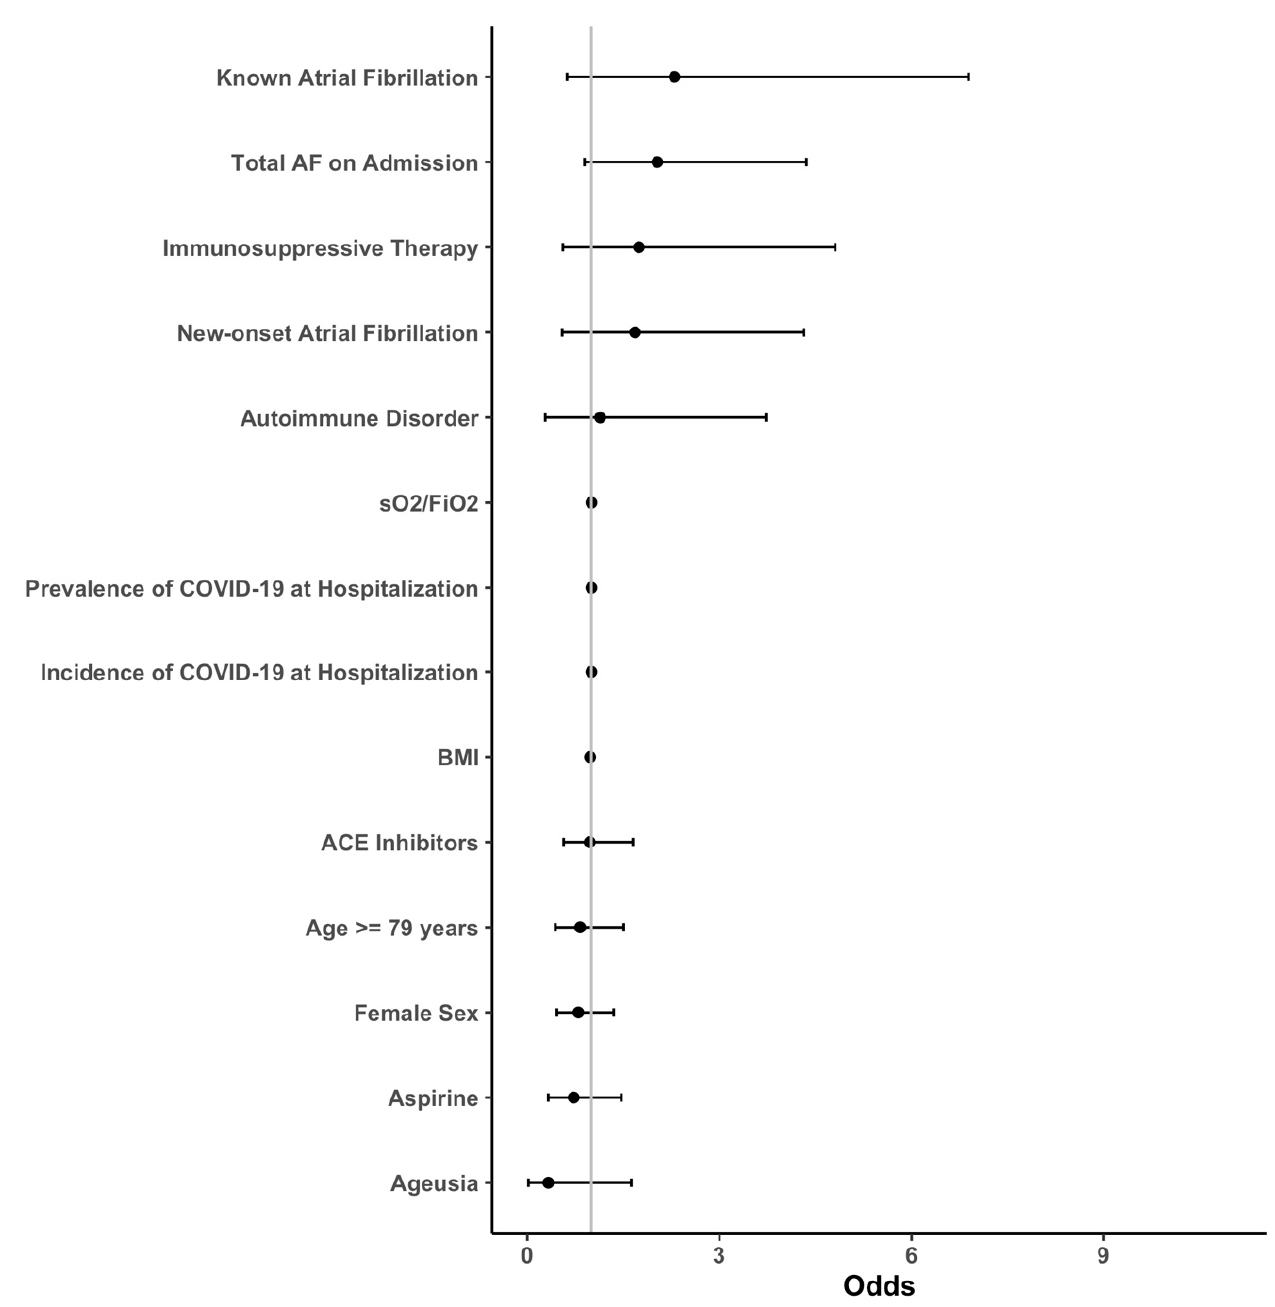
Figure 3. Forest plots of the secondary outcome “Repeated Hospitalization”. The transfer risk for repeated hospitalization was assessed by sequential logistic models with a stepwise reduction based on the Aikake information criterion. Abbreviations: ACE = angiotensin-converting enzyme; AF = atrial fibrillation; BMI = body mass index; sO 2 = oxygen saturation; FiO 2 = fraction of inspired oxygen; COVID-19 = coronavirus disease 2019.